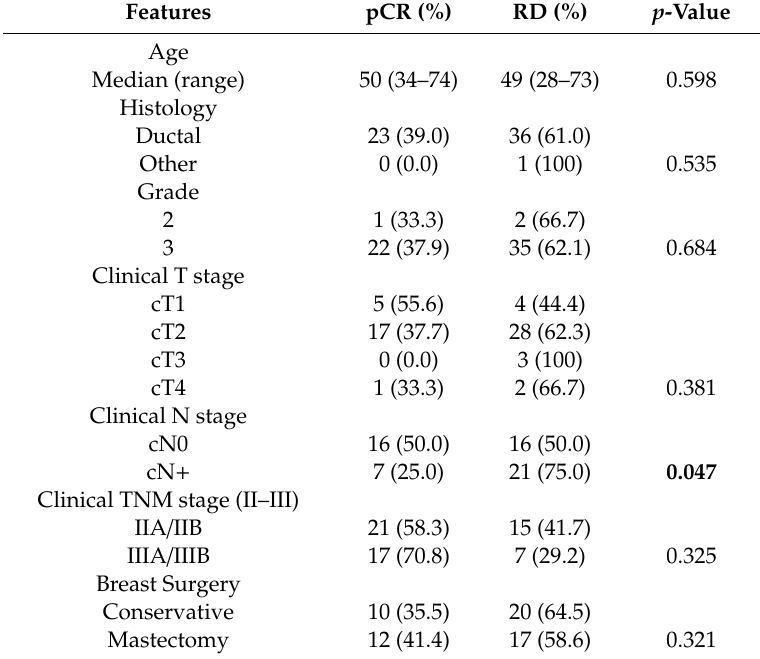
Table 2. Association between clinical and pathological features and response to neoadjuvant chemotherapy (NACT).